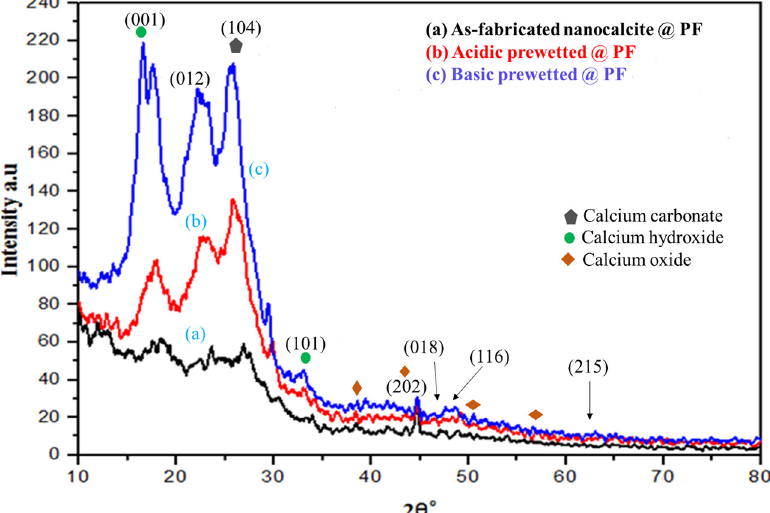
Figure 2. XRD of ( a ) as-fabricated nanocalcite @ PF, ( b ) acidic prewetted nanocalcite @ PF, ( c )